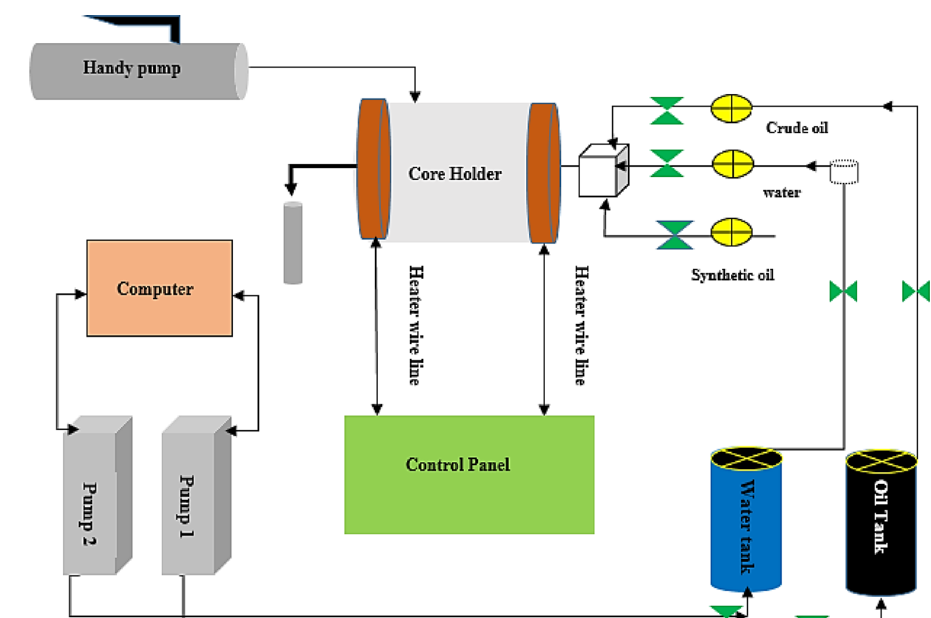
Fig. 4 A schematic of core flooding set